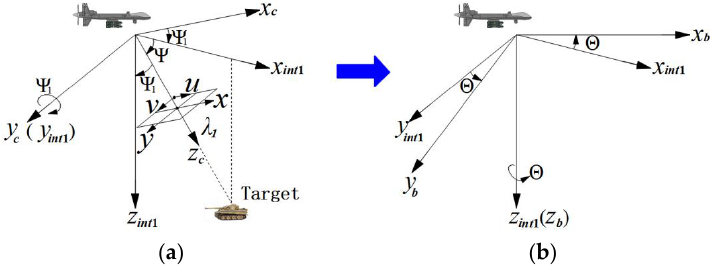
Figure 4. The coordinate frames relation: Azimuth-elevation rotation sequence between camera and body frames. ( a ) camera frame; ( b ) body frame.